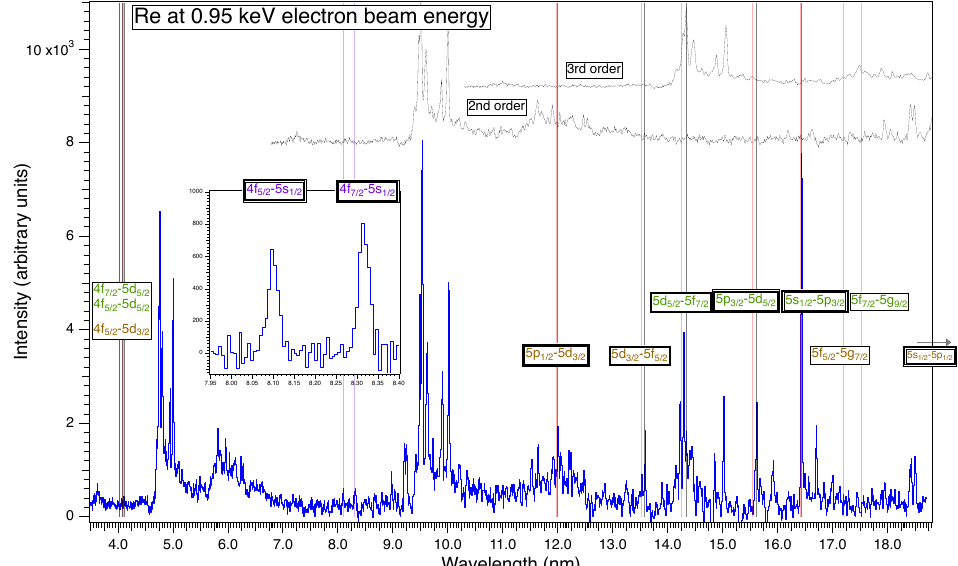
Figure 4. Experimental observation and identification of E3 and E1 transitions in Ag-like Re at 0.95 keV electron beam